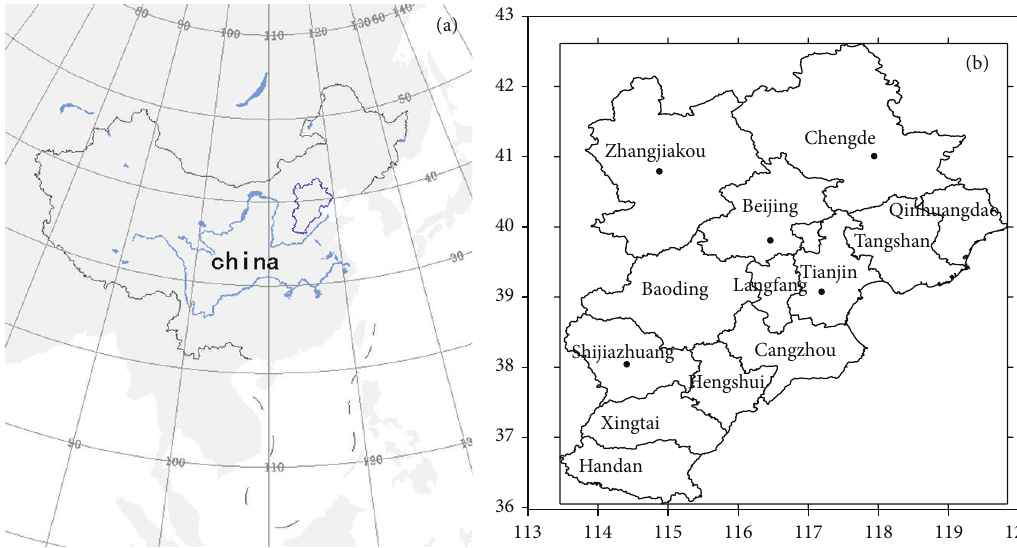
Figure 1: The geographic location of the Beijing-Tianjin-Hebei region (a) and the distribution of the thirteen cities (b).